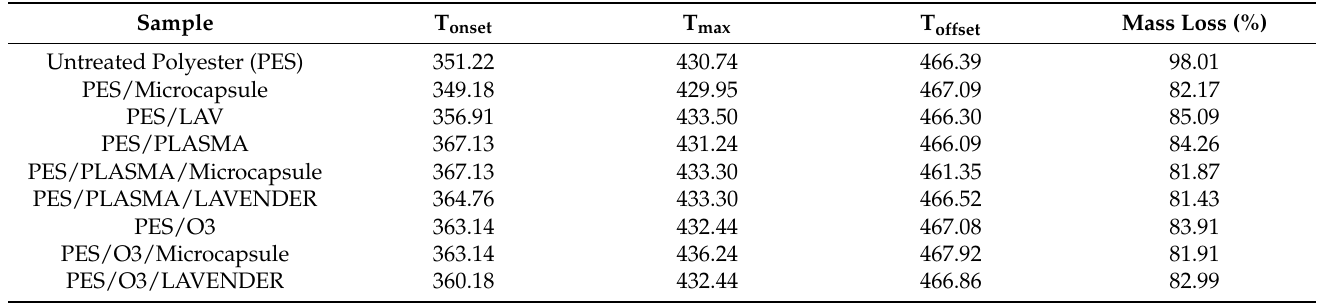
Table 1. The TGA data of samples: initial degradation temperature (T i ), major degradation tempera- ture (T max ), final degradation temperature (T f ), and mass loss of polyester